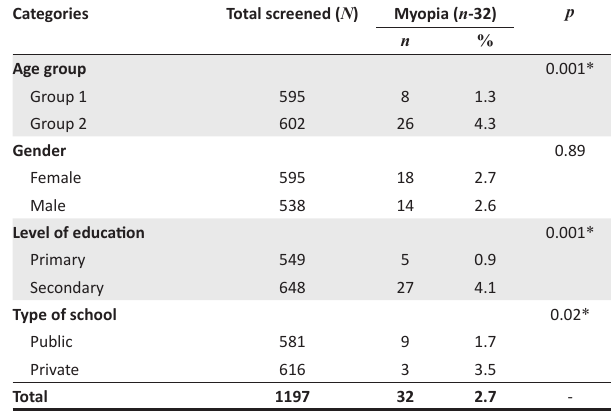
TABLE 1: Characteristics of the study population. Characteristics